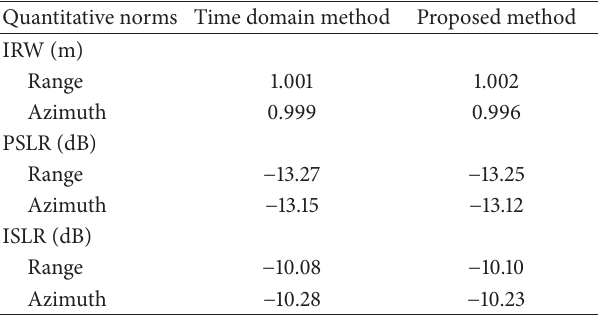
Table 3: Performance of point target (PT9) based on different simulation